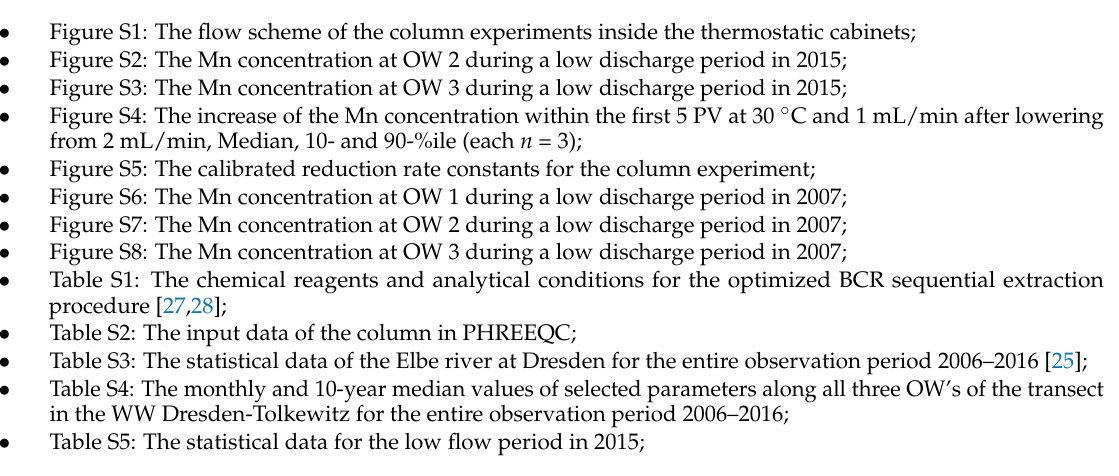
Figure S1: The flow scheme of the column experiments inside the thermostatic cabinets; Figure S2: The Mn concentration at OW 2 during a low discharge period in 2015; Figure S3: The Mn concentration at OW 3 during a low discharge period in 2015; Figure S4: The increase of the Mn concentration within the first 5 PV at 30 ◦ C and 1 mL/min after lowering from 2 mL/min, Median, 10- and 90-%ile (each n = 3); Figure S5: The calibrated reduction rate constants for the column experiment; Figure S6: The Mn concentration at OW 1 during a low discharge period in 2007; Figure S7: The Mn concentration at OW 2 during a low discharge period in 2007; Figure S8: The Mn concentration at OW 3 during a low discharge period in